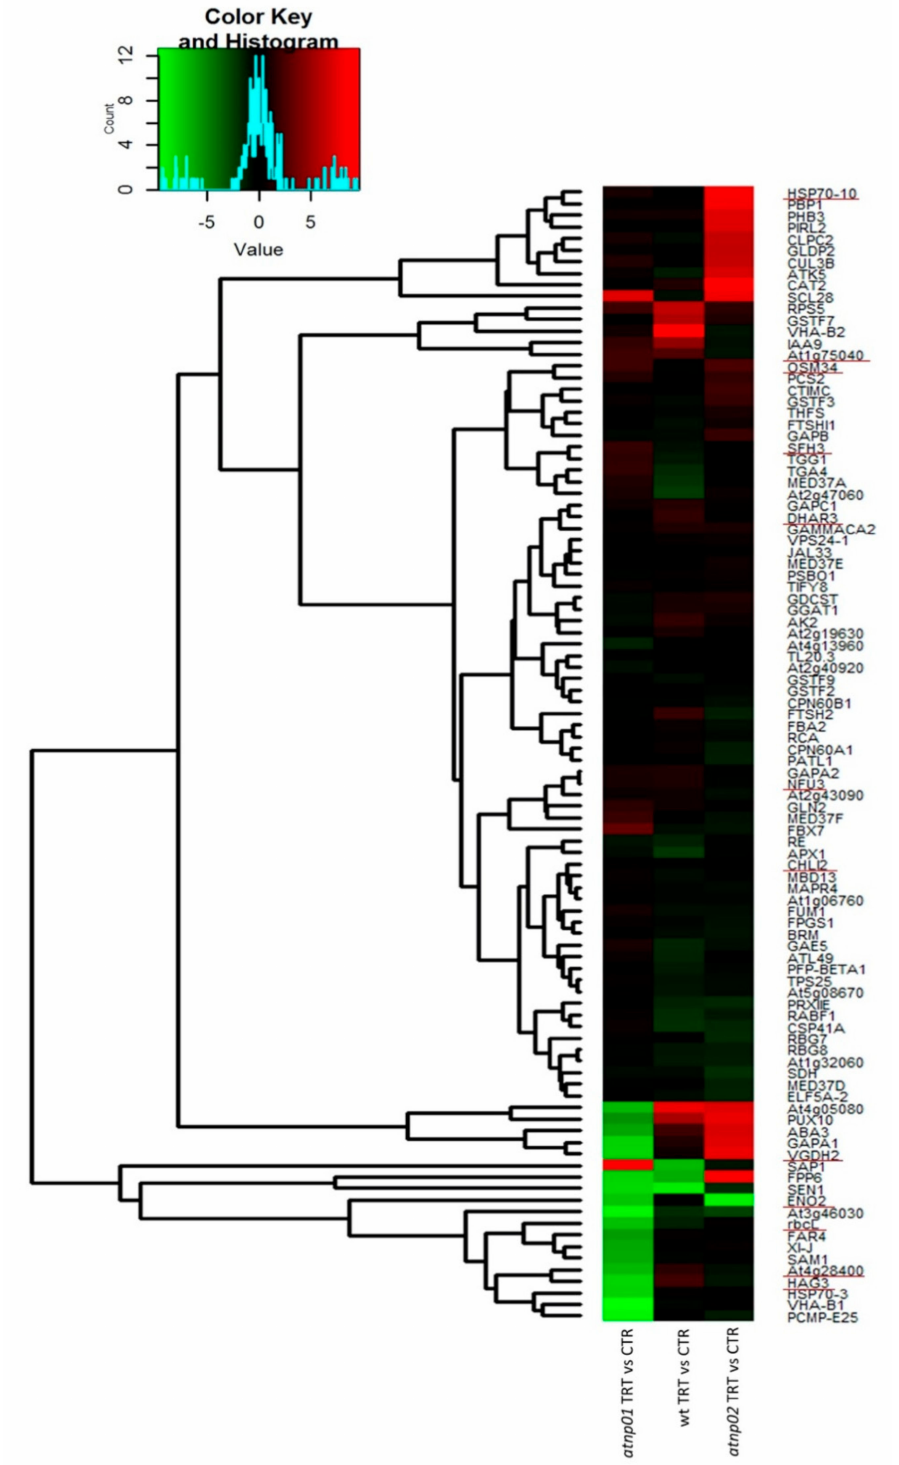
Figure 2. Heat map representing the effect on the A. thaliana proteome of CdS QDs (80 mg L − 1 ) for wt and for the mutant lines atnp 01 and atnp 02. This heat map was obtained, similarly to Figure S5, by dividing the abundances of treated samples by the control samples. The proteins underlined in red are those in common among the wt and the two mutants atnp 01 and atnp 02, those that were found in the networks related to the mutated genes in the two mutants and those in common with the proteomic study with PF2D and the